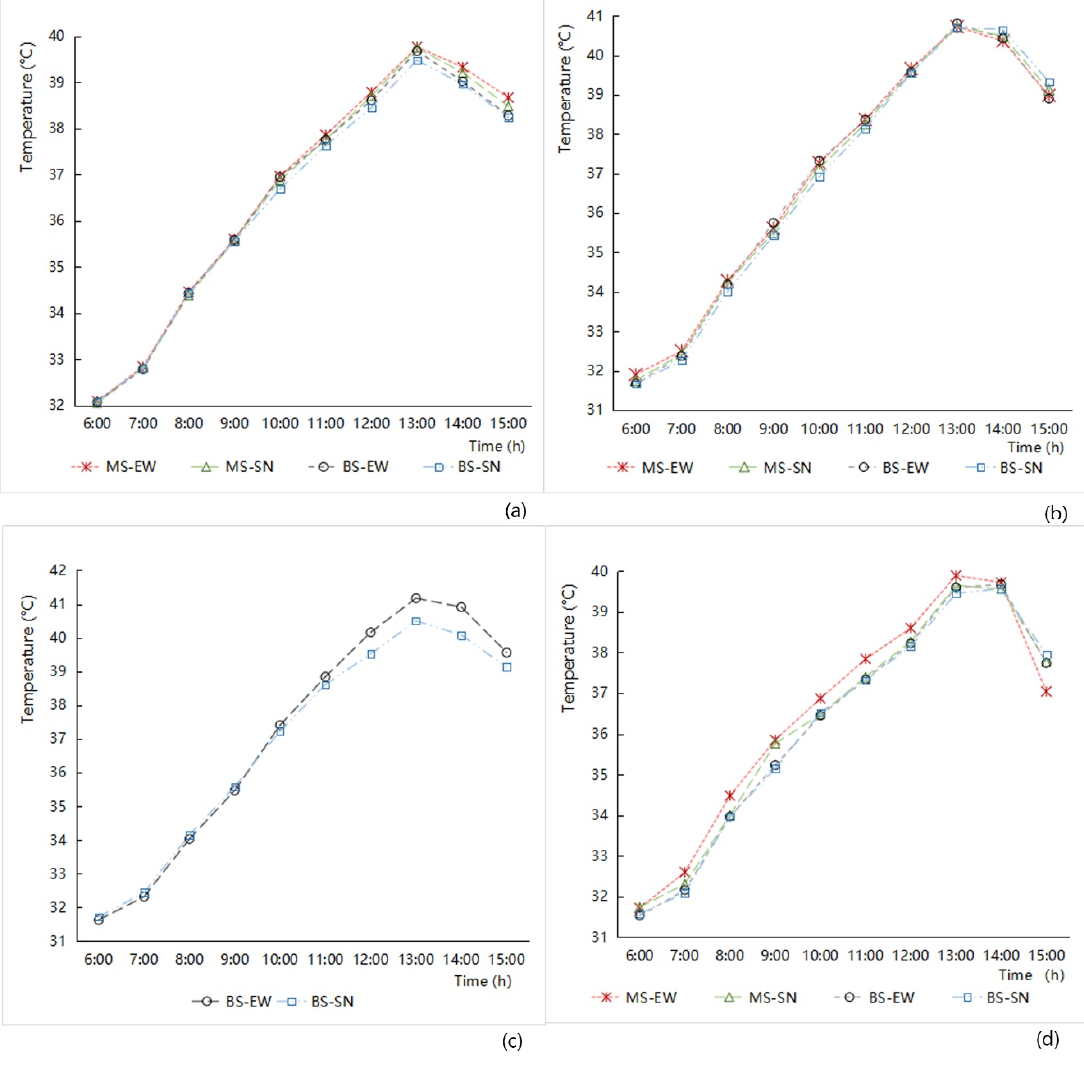
Figure 5. The hourly air temperature variation analysis related to different grade width and orientation of street space from 6:00 to 15:00 in the four study areas. ( a ) Old downtown; ( b ) Gubei international community; ( c ) Anting New Town; ( d ) New Jiangwan Town.